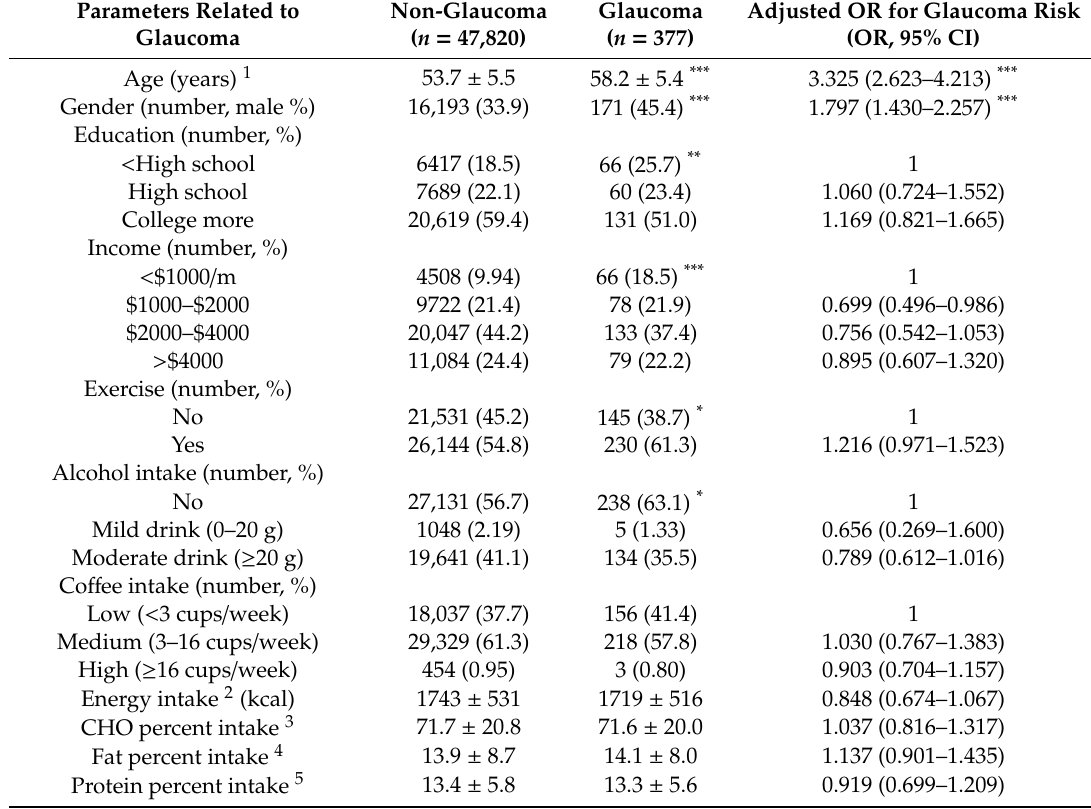
Table 1. Socioeconomic and lifestyle characteristics of the participants according to glaucoma